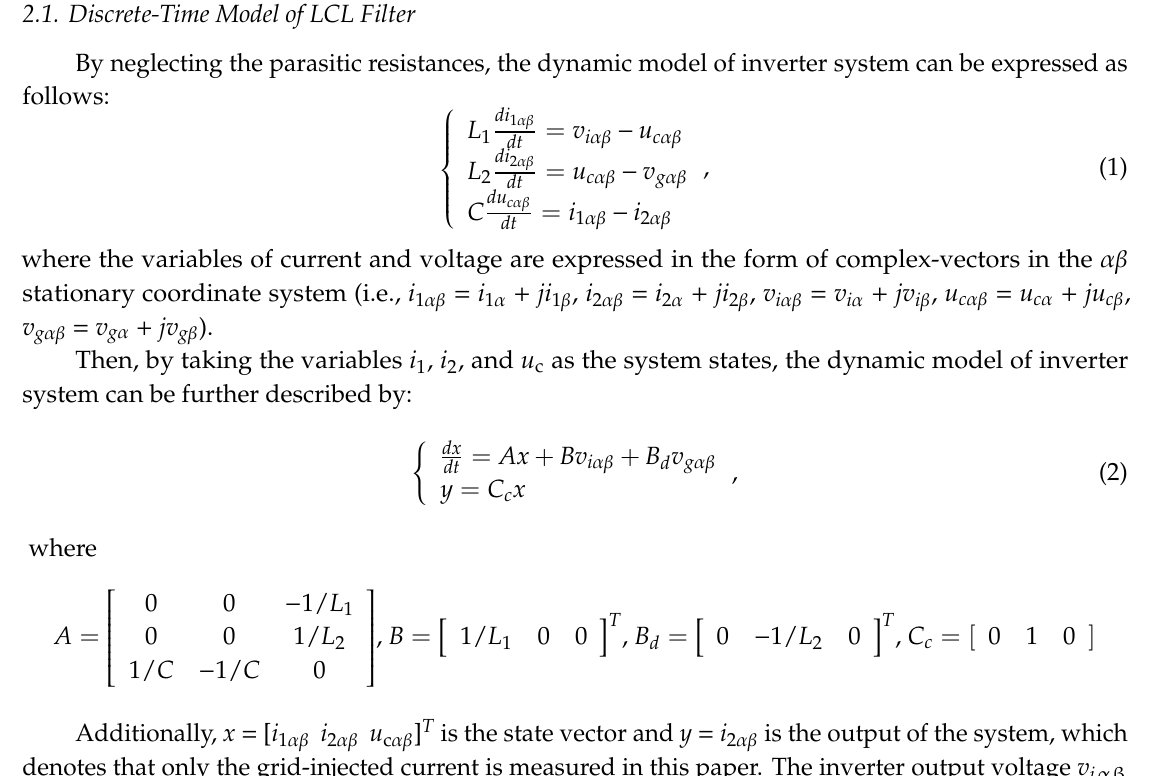
Figure 1. Proposed FCS-MPC algorithm for inductance-capacitance-inductance (LCL)-filtered grid-tied inverter with full status estimations under the unbalanced grid voltage condition.